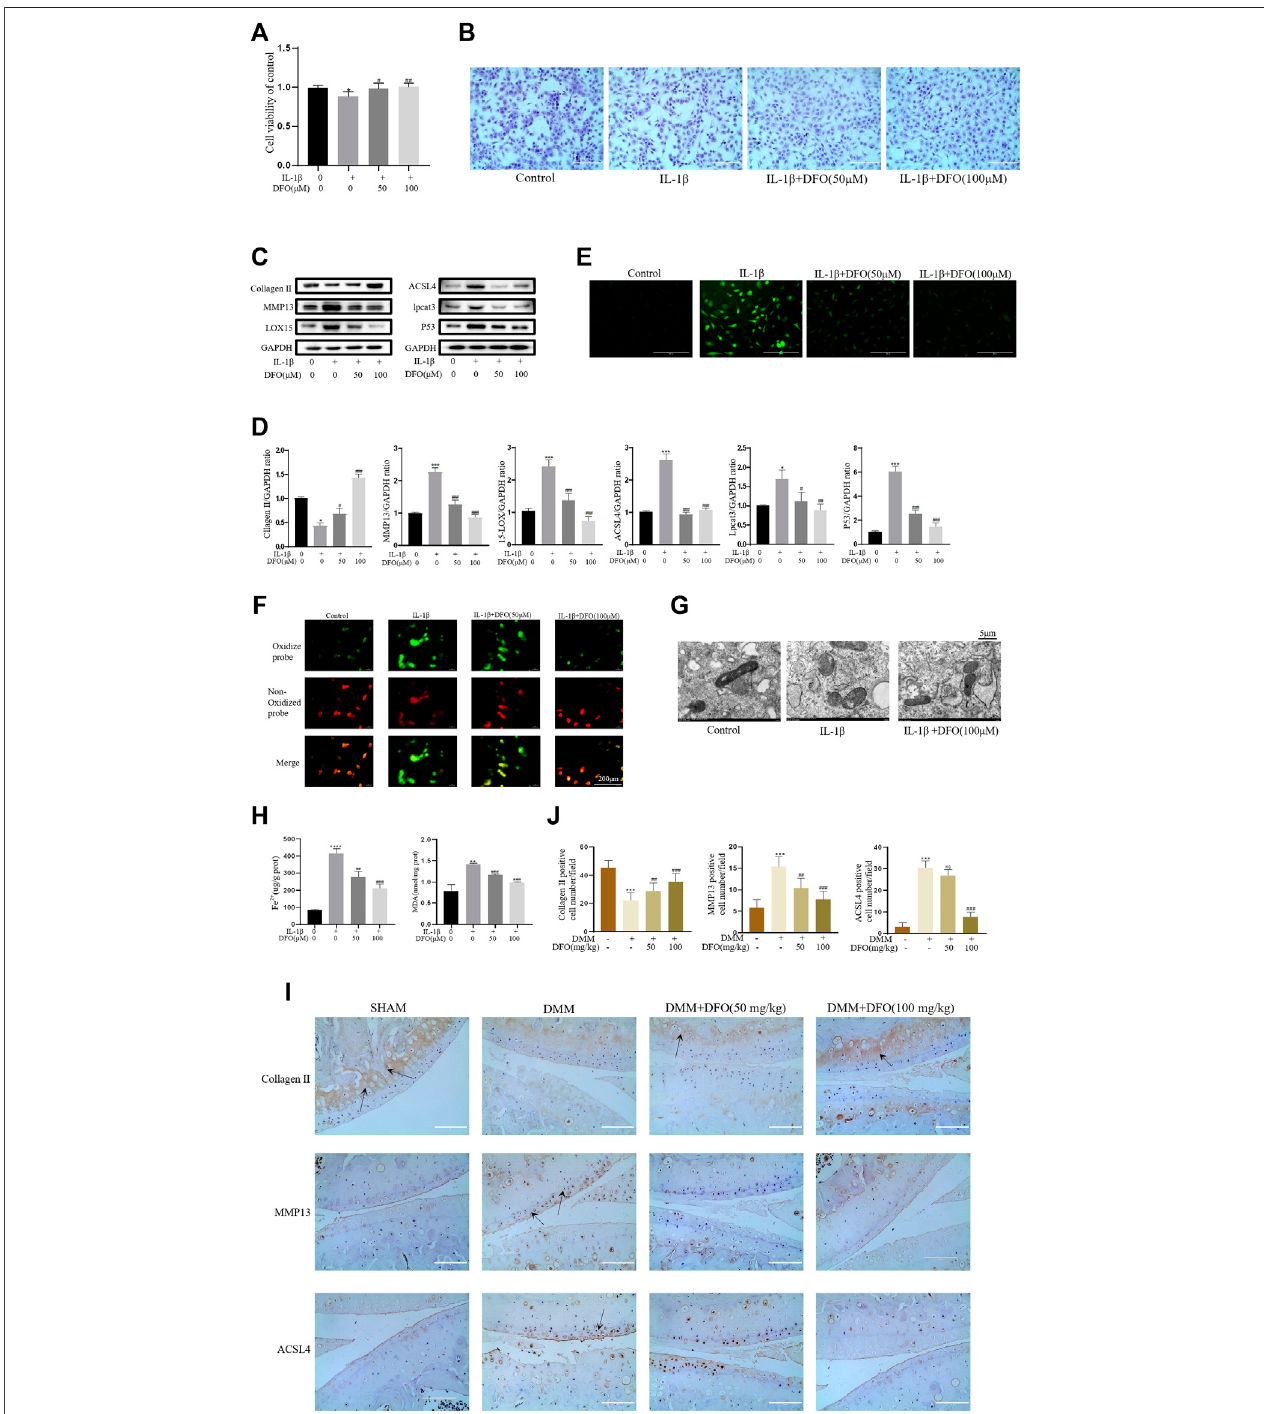
FIGURE4| DFO attenuated the in fl ammatory responseand ECMdegradation ofchondrocytes inducedbyIL-1 β via inhibiting chondrocytesferroptosis. (A,B) Cell viability determined by CCK-8 assay and toluidine blue staining. (C,D) The protein expression levels of collagen Ⅱ , MMP13, ACSL4, LOX15, lpcat3, and P53 when treated by IL-1 β (10 ng/ml) with 50 and 100 μ M DFO or equal volume of DMSO were detected by Western blot, and band density ratios of collagen Ⅱ , MMP13, ACSL4, LOX15,lpcat3,andP53toGAPDHwerequanti fi edbydensitometry( n =3). (E) IntracellularROSleveldetectedbyDCFH-DA fl uorescentprobe(scalebar:200 µm). (F) Intracellular lipid-ROS level detected by C11 BODIPY fl uorescent probe (scale bar: 200 µm). Red, reduced form of C11-BODIPY; green, oxidized form of C11- BODIPY. (G) The ultrastucture of mitochondria observed via transmission electron microscopy (scale bar: 5 µm). (H) The intracellular level of MDA and Fe 2+ was determined using the MDA assay kit and iron assay kit ( n = 3). (I) The collagen Ⅱ , MMP13, and ACSL4 expression levels in the cartilage samples were measured using